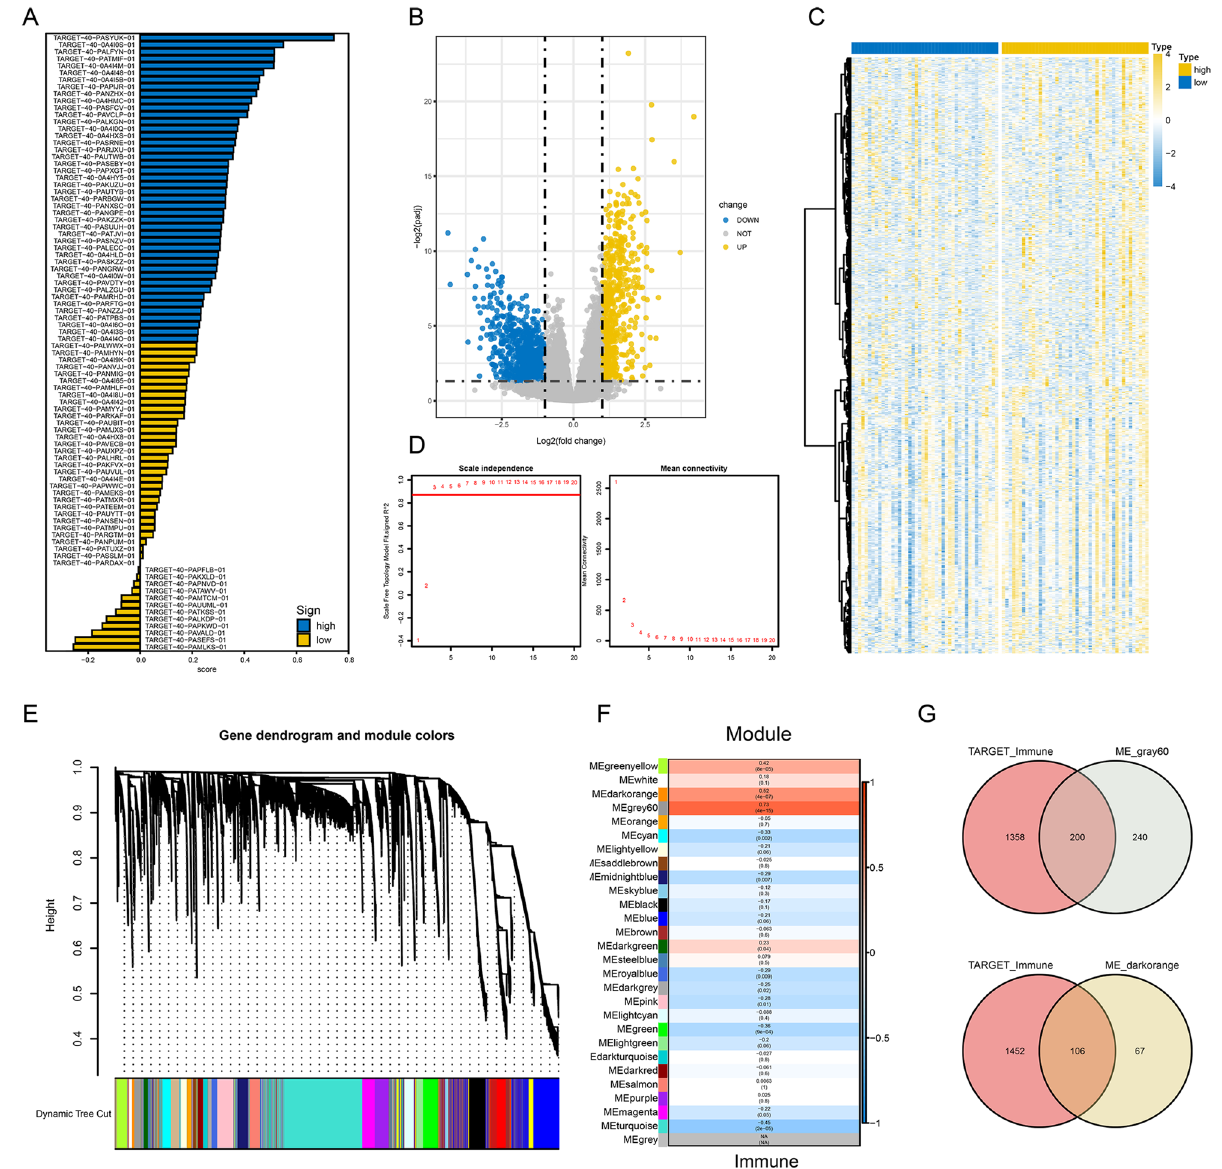
Figure 3. Screening of immune gene candidates in the TARGET-OS dataset. ( A ) Overview of the association of TARGET-OS samples with the immune score. Samples ranked from high to low based on their immune score. ( B , C ) Volcano plots and heatmaps of differentially expressed genes (DEGs) according to high and low immune scores. ( D ) Analysis of scale-free fit parameter and mean connectivity for different soft-thresholding power. ( E , F ) Dendrograms and heatmaps showing gene modules associated with the immune score. In Fig. 3F, the p values and correlation values are shown inside and outside the brackets, respectively. ( G ) Venn diagram representing the intersection of genes within the gray60 and dark orange modules, which denote immune- related genes and DEGs, the heatmaps (Fig. 8A,B). After differential gene expression analysis, a PPI network was constructed using the STRING database. Eight hub genes, namely CD3D , CD8DA , CD3E , IL2 , CD2 , MYH6 , MYH7 , and MYL2 , were extracted using the CytoHubba plugin (Fig. 8C,D). As shown in Fig. 7C, when the confidence score > 0.9 (high- est confidence), only 72 nodes (genes) existed in the network, and 58 edges (edge) connected them. The average node degree was 0.229, avg. local clustering coefficient 0.113, expected number of edges 18, and PPI enrich- ment p-value 8.59–14 e-14. Subsequently, we established molecular regulatory networks, which represent the collection of regulatory interactions occurring between transcription factors (TFs)/miRNAs and the identified hub genes (Fig. 8E,F). We further performed GO and KEGG pathway analyses, GSEA, and ssGSEA to identify potential downstream signaling pathways of the 4-gene prognosis model. The GO enrichment analysis showed that the DEGs were significantly enriched in the transporter activity, transmembrane transporter activity, syn- apse part, sensory perception, etc. (Fig. 9A, Table 2). The KEGG pathway analysis indicated the complement